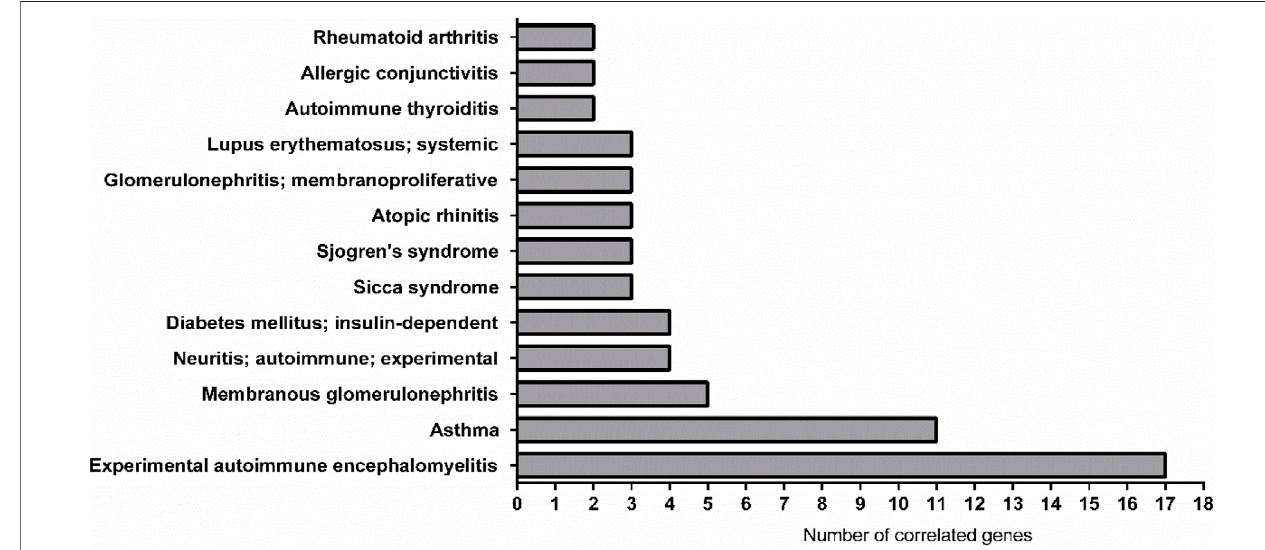
FIGURE 6 | Graphical representation of the most linked immune system diseases with the genes list in AMDi. The most linked diseases were experimental autoimmune encephalomyelitis (EAE, linked 17 genes) and asthma (linked 11 genes).